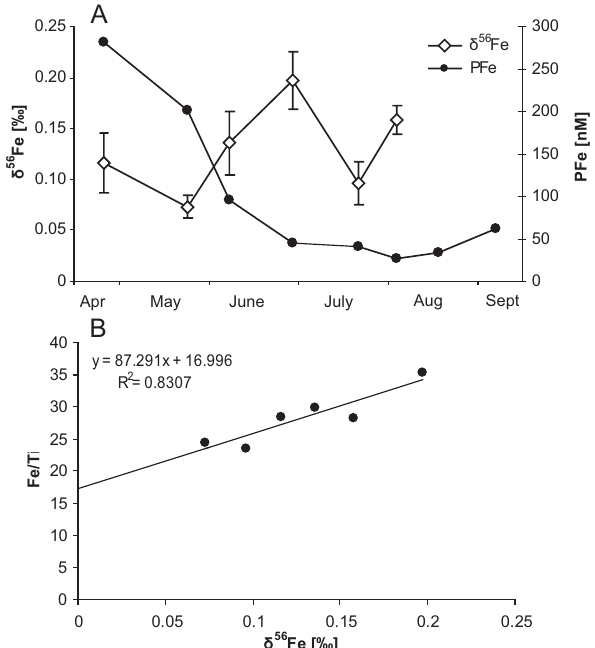
Fig. 6. PFe in the Bothnian Sea station 2006 (filled dots) and Fe iso- topic signatures of the suspended matter (open diamonds) (a) . Error bars indicate instrumental precision ± 2 STD of the mean. Regres- sion between Fe isotopic signature and Fe/Ti ratios of the suspended matter (PFe) (b) .